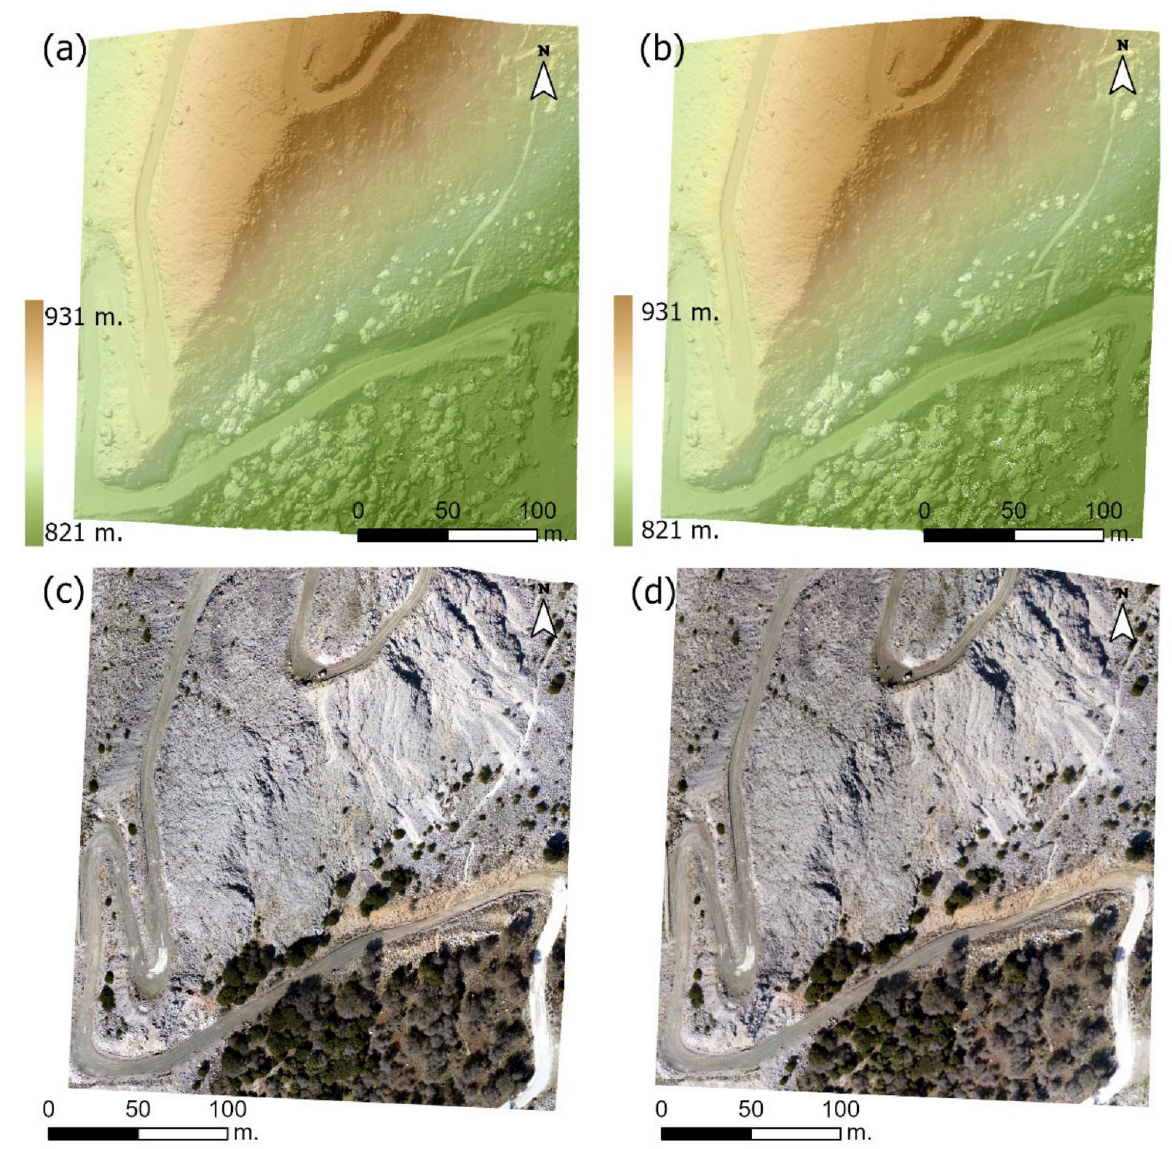
and 6.26 hectares in case B.